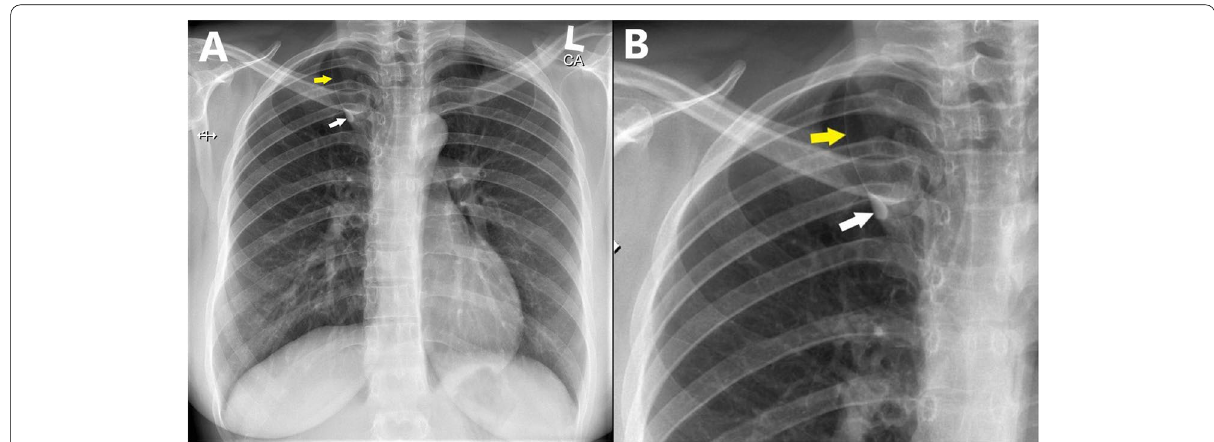
Fig. 2 a , b Chest radiograph of normal azygos lobe and fissure. a Frontal chest radiograph demonstrates the azygos fissure (yellow arrow) and azygos vein (white arrow). b Magnified image of the same radiograph demonstrates the azygos fissure (yellow arrow) and the tear drop shape of azygos vein (white arrow)